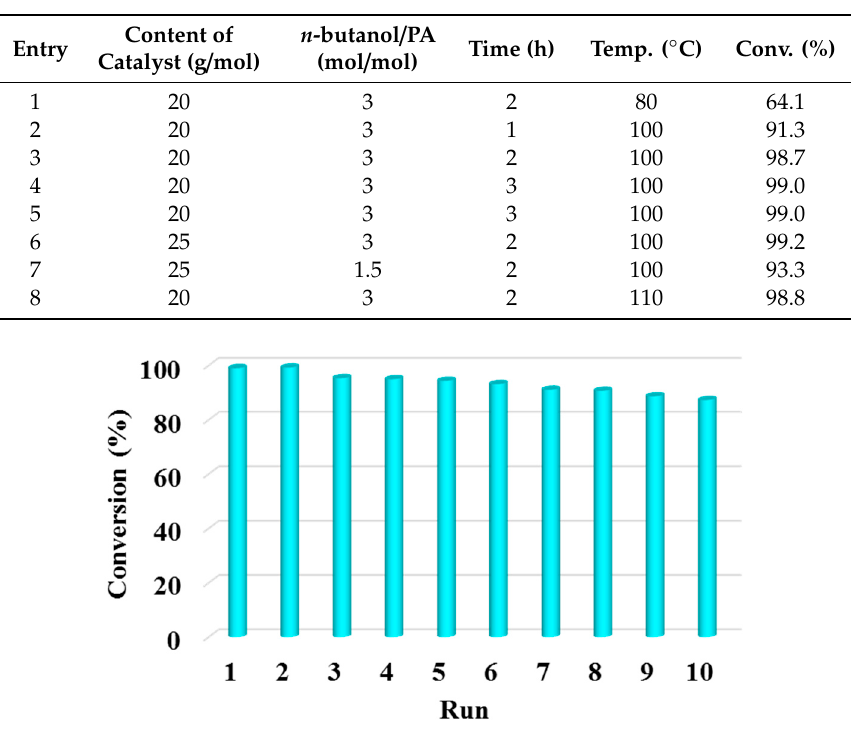
Figure 10. Reusability of MSA/UiO-66 in the esterification of PA with n -butanol.